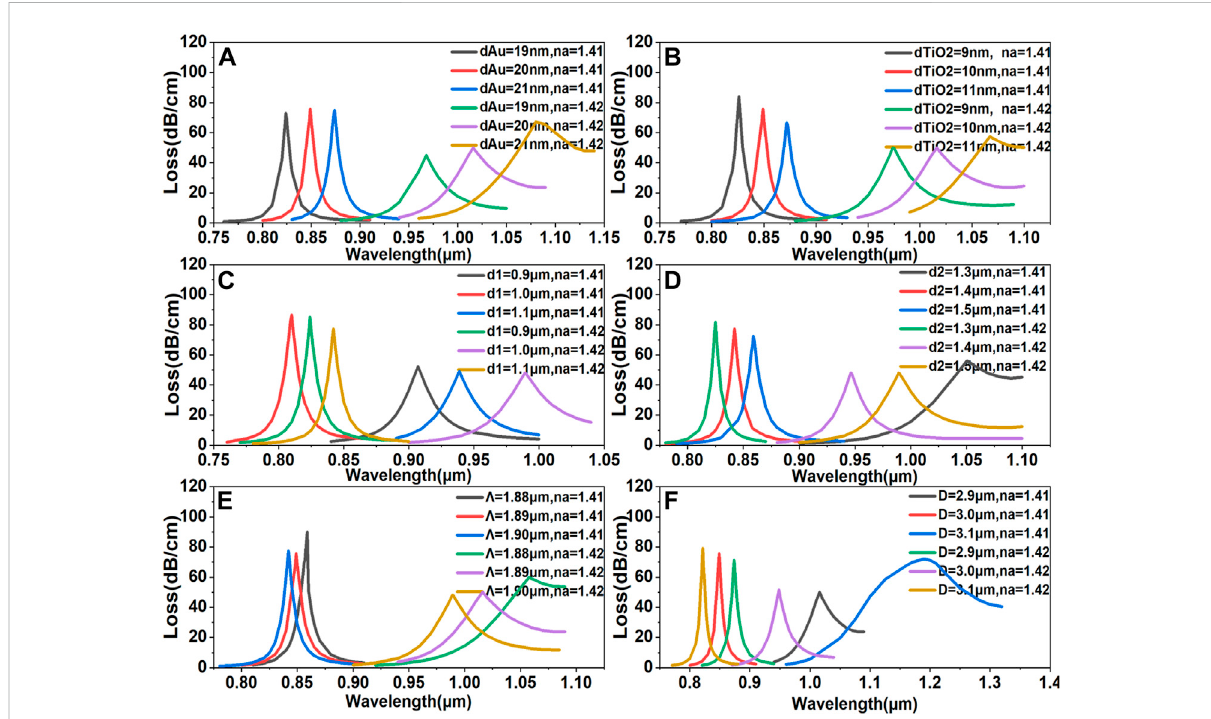
FIGURE 3 Con fi nement loss due to change in (A) gold thickness. (B) TiO 2 thickness. (C) Air pore diameter d 1 . (D) Air pore diameter d 2 . (E) Adjacentair hole spacing Λ . (F) Polishing depth